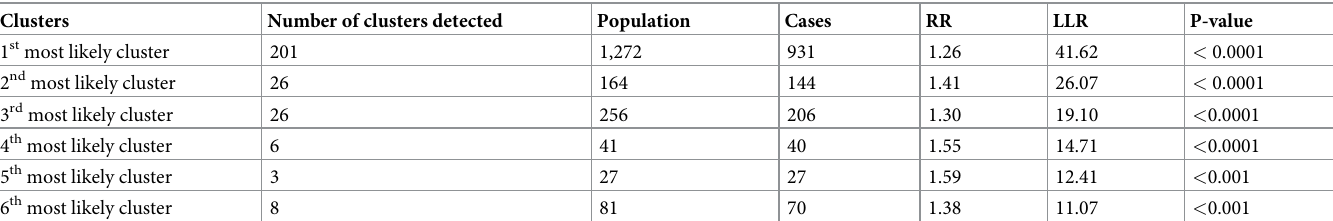
Table 4. Significant and most likely clusters spatial clusters of unsafe child stool disposal in Ethiopia, EDHS 2016.